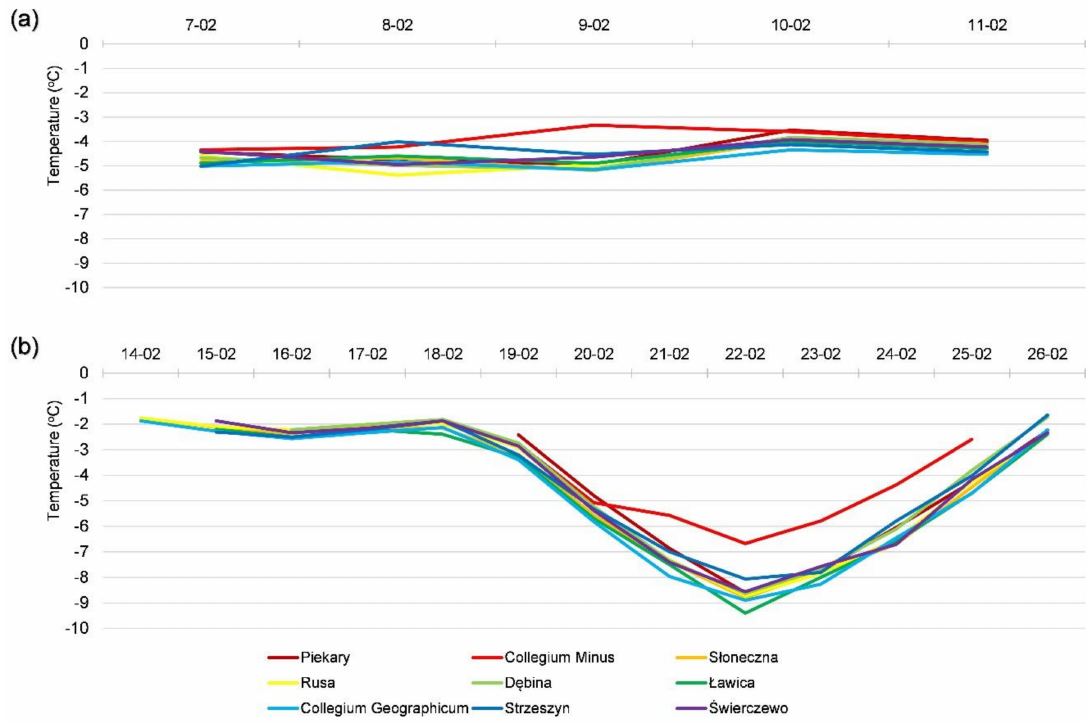
Figure 5. Tmax during the cold wave of 7–11 February 2010 ( a ) and 14–26 February 2011 ( b